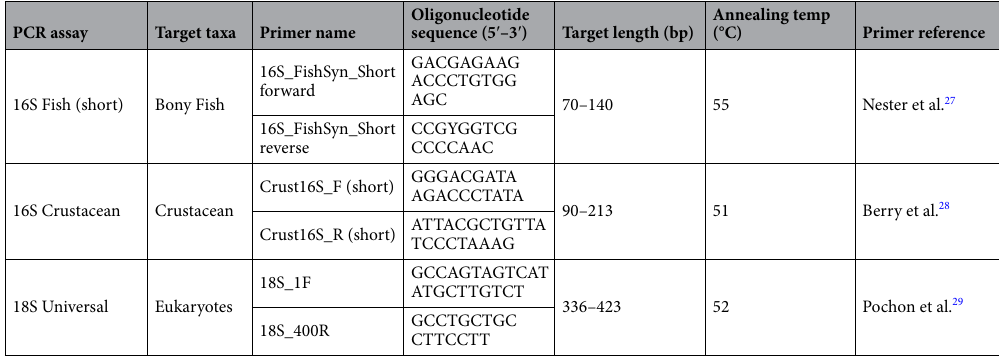
Sampling and sequencing statistics. The three metabarcoding assays yielded a total of 35,698,221 sequencing reads across 159 samples. The mean number of filtered sequences (post-quality, denoising and chi- mera filtering) was 74,014 ± 73,211 per replicate sample for the 16S Fish (short) assay; 66,152 ± 115,417 per rep- licate sample for the 16S Crustacean assay; and 22,968 ± 16,704 per replicate sample for the 18S Universal assay (Tables S2, S3). The 16S Crustacean assay did yield unbalanced read numbers (post-quality filtering) between